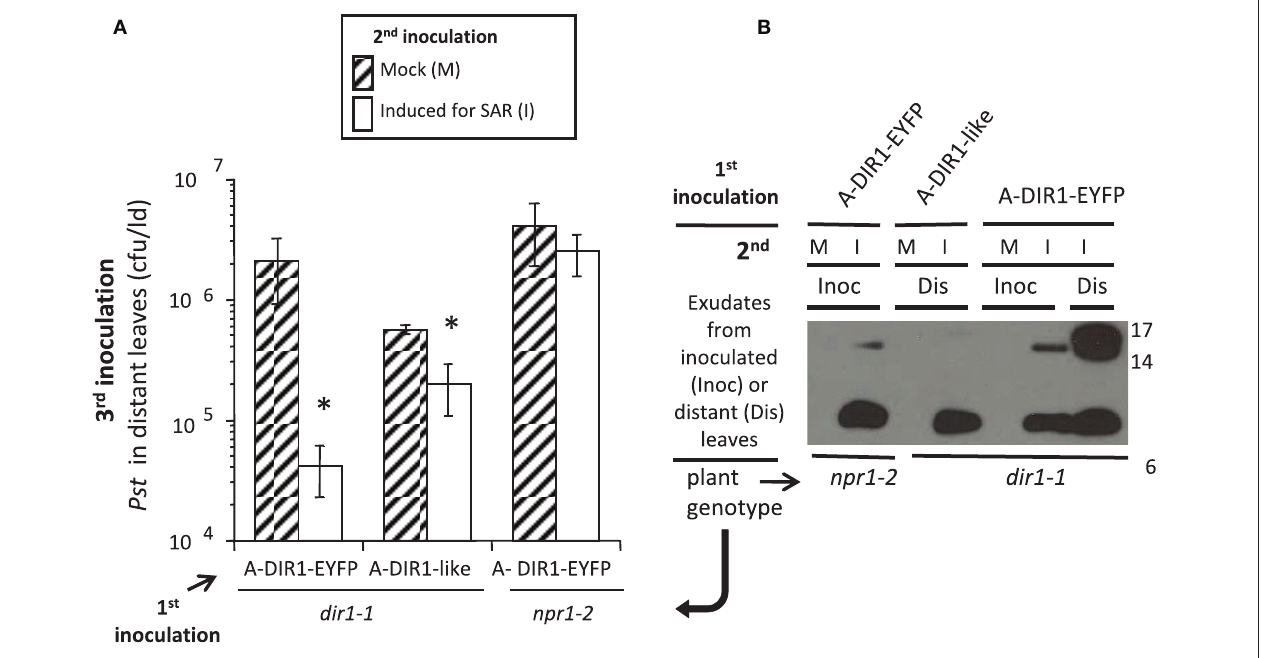
FIGURE 7 | DIR1-like Agro-SAR assay and DIR1-antibody signals in distant leaf petiole exudates. (A) The Agro-SAR assay was performed as in Figure S8. (B) Petiole exudates were collected (20–46hpi) from mock-inoculated (M) or SAR-induced (I) lower leaves (Inoc) and from distant leaves (Dis). Exudates were lyophilized and subjected to protein gel